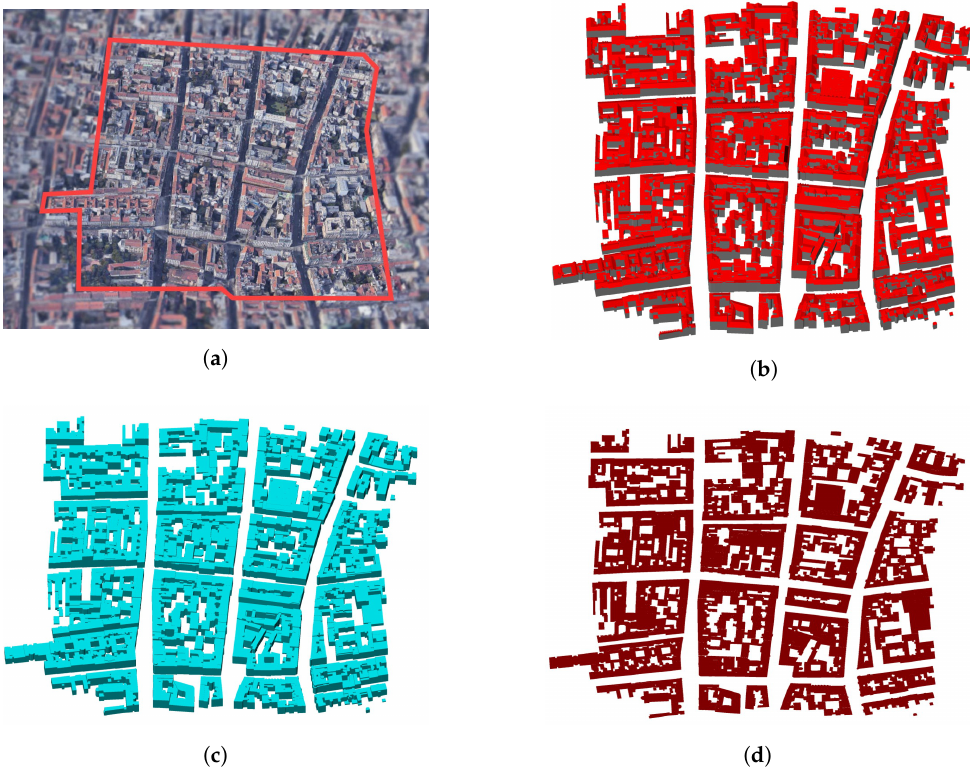
Figure 9. ( a ) Visual representation of the selected buildings in Vienna using an underlying image from Google Maps [139]. Image adapted to highlight the considered area; ( b ) representation of open LoD2 CityGML building models; ( c ) LoD1 models transformed from LoD2 models; ( d ) representations of the transformed LoD0 CityGML building models. The LoD0 models are transformed from LoD2